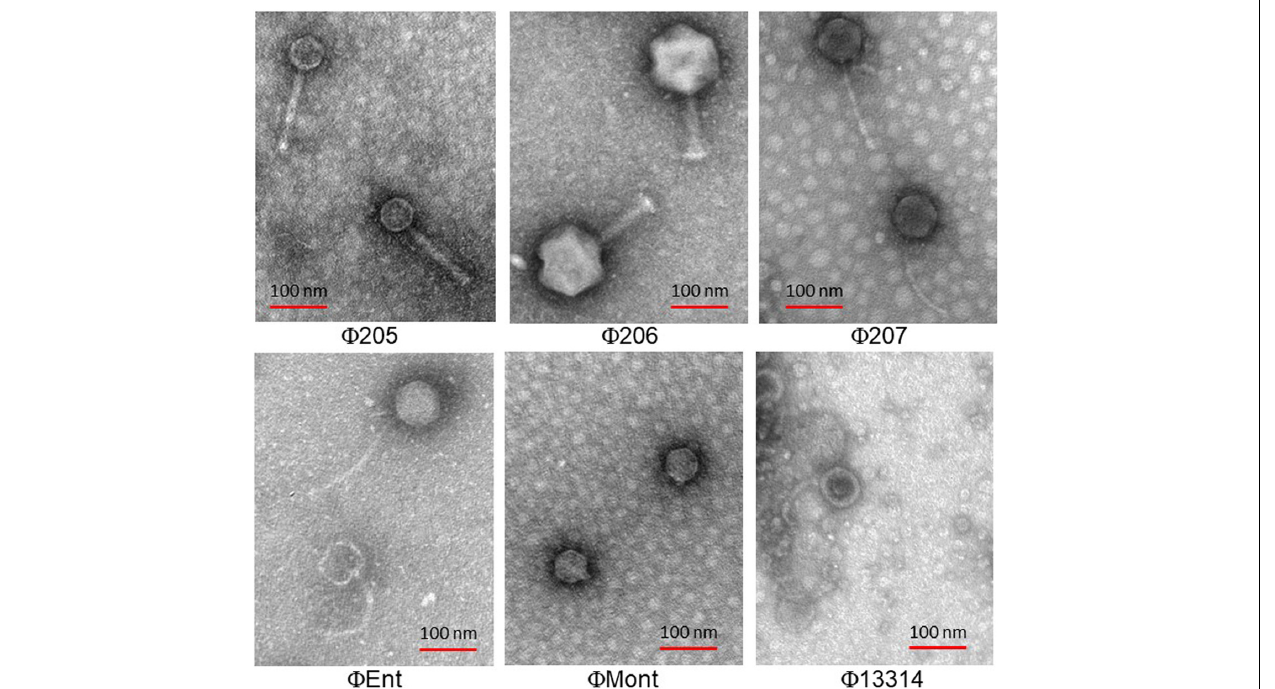
FIGURE 1 | Transmission electron micrographs of six Salmonella phages isolated from turkeys.